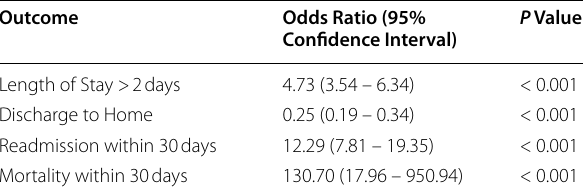
Table 4 Additional 30-day adverse events associated